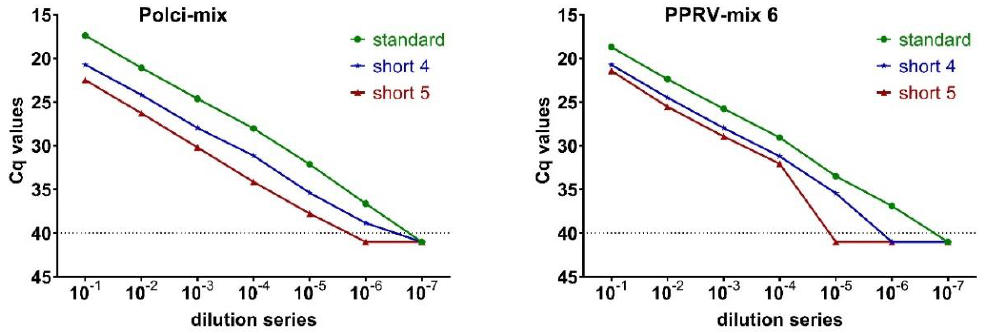
Figure 3. Test series for the establishment of a high-speed RT-qPCR: differences in the Cq-values of the standard (“standard”) and maximal shortened protocols (“short 4” and “short 5”) for two different primer–probe mixtures: Polci-mix and PPRV-mix